Question: Compose a caption that would accompany this figure in a paper.
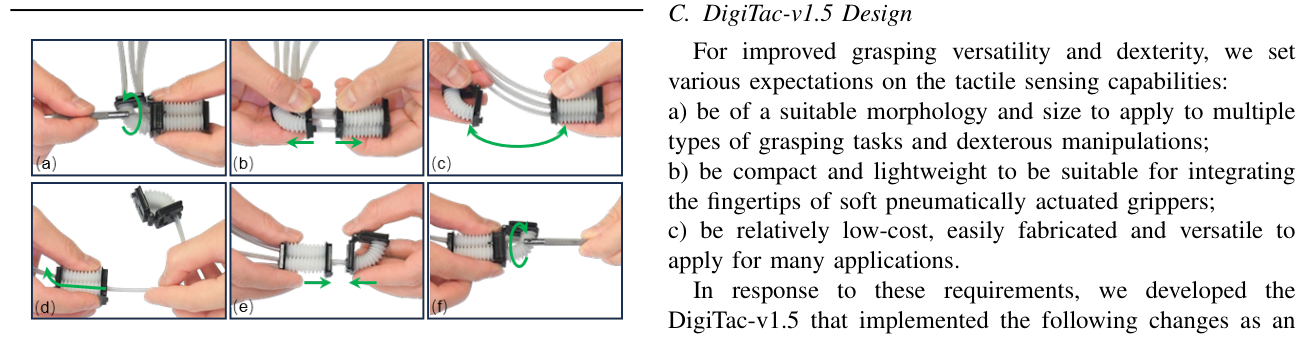
Answer: Reconfiguration process from Rot-Dex finger to Dex-Rot finger. (a) Unscrew the bolts. (b) Separate two joints. (c) Exchange places. (d) Enter the tube. (e) join the two joints. (f) screw the bolts.